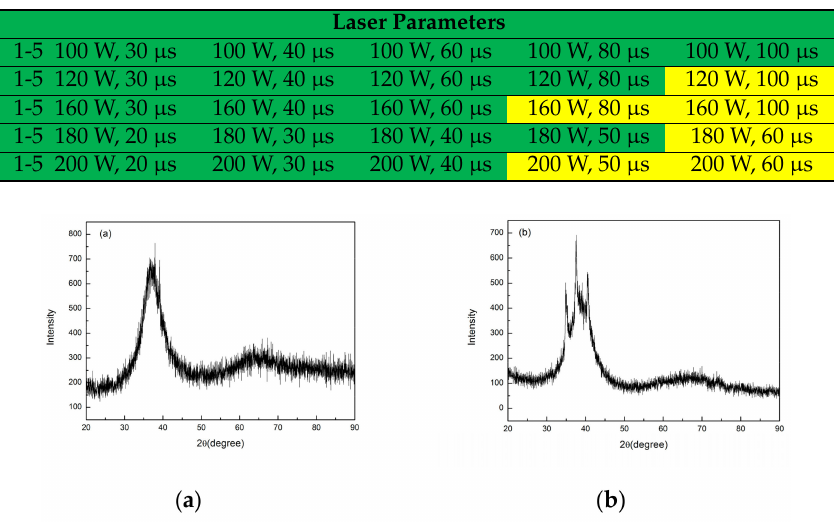
Figure 2. Results of primary study on the laser parameters range. Table 2. Summary of the SLM parameters in building 3D specimens, (green) nearly full amorphous structure, (yellow) partially crystallized.